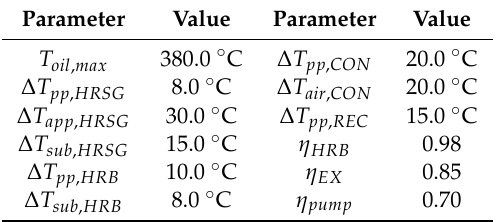
Table 4. ORC power plant data in design conditions—parameters not depending on working